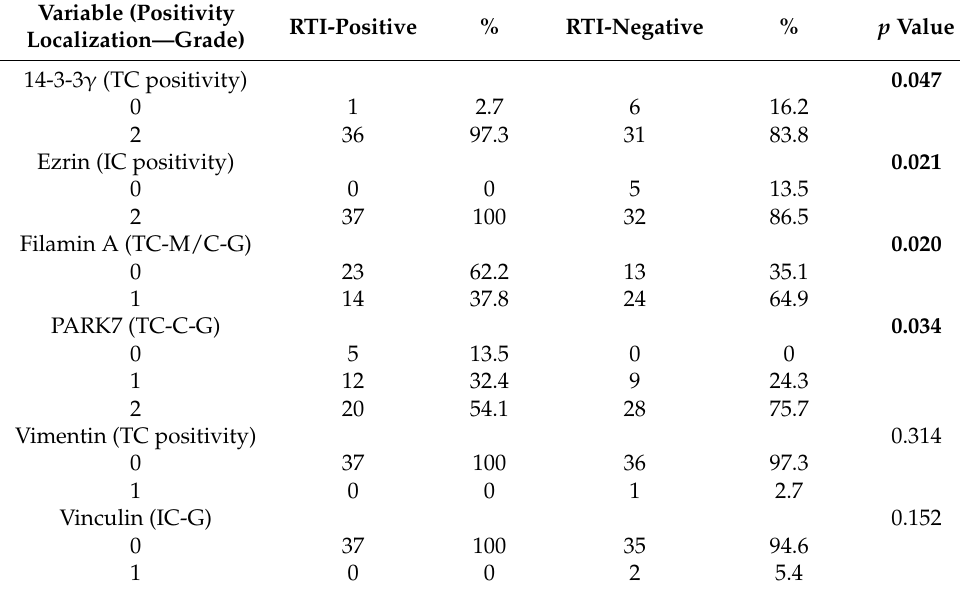
Table 3. Protein categorization during statistical analysis of IHC data. Variable (Positivity Localization—Grade)